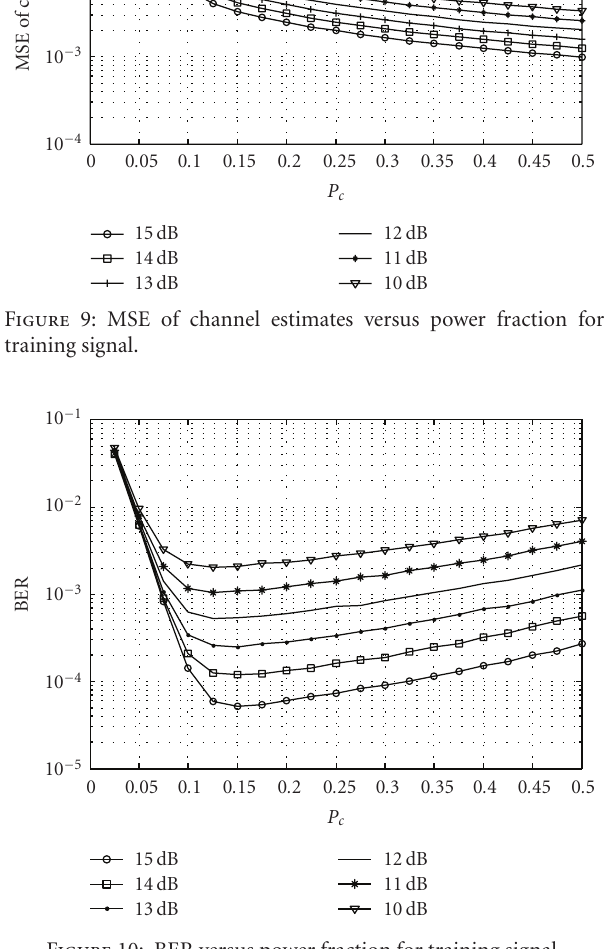
Figure 10: BER versus power fraction for training